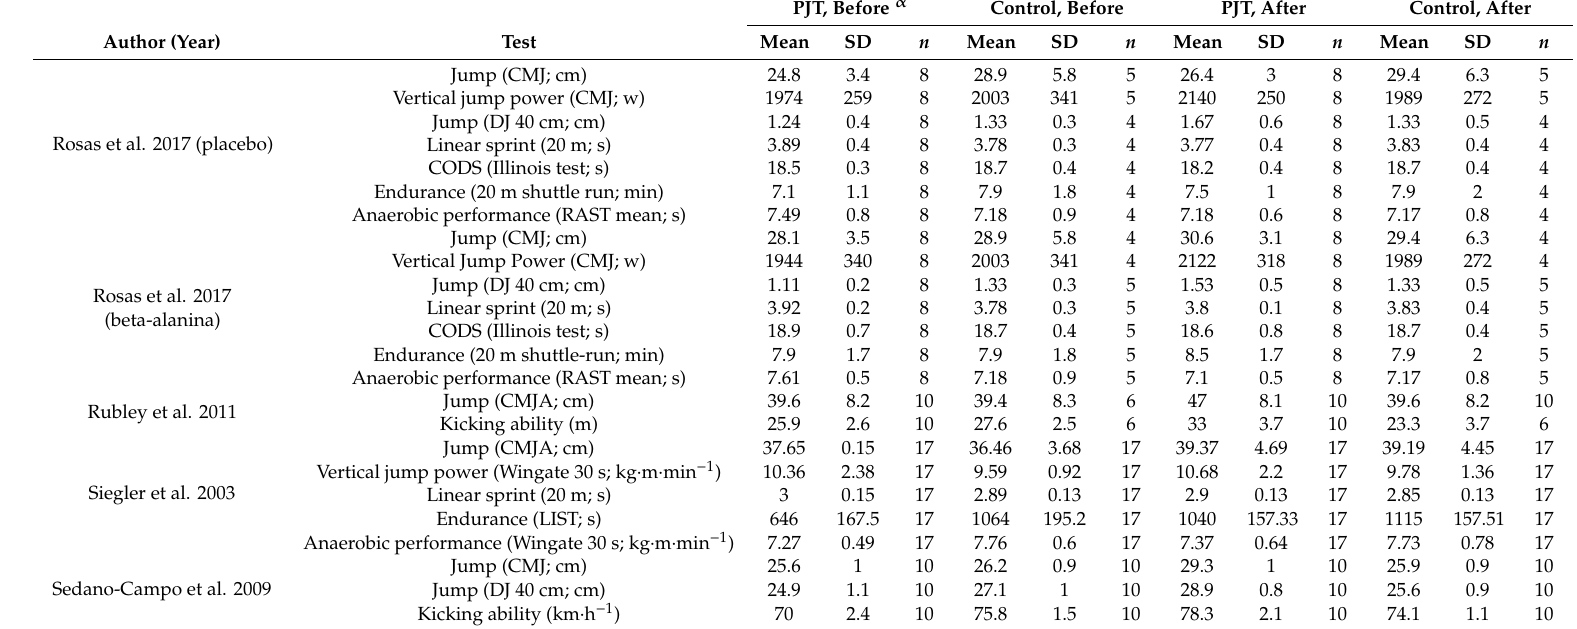
α : before and after values denotes the mean ± standard deviation for each group before and after the intervention, respectively. Note: abbreviations descriptions ordered alphabetically. CMJ: countermovement jump; CMJA: countermovement jump with arm swing; CODS: change of direction speed; DJ: drop jump; LIST: Loughborough intermittent shuttle test; RAST: repeated anaerobic sprint test; SD: standard